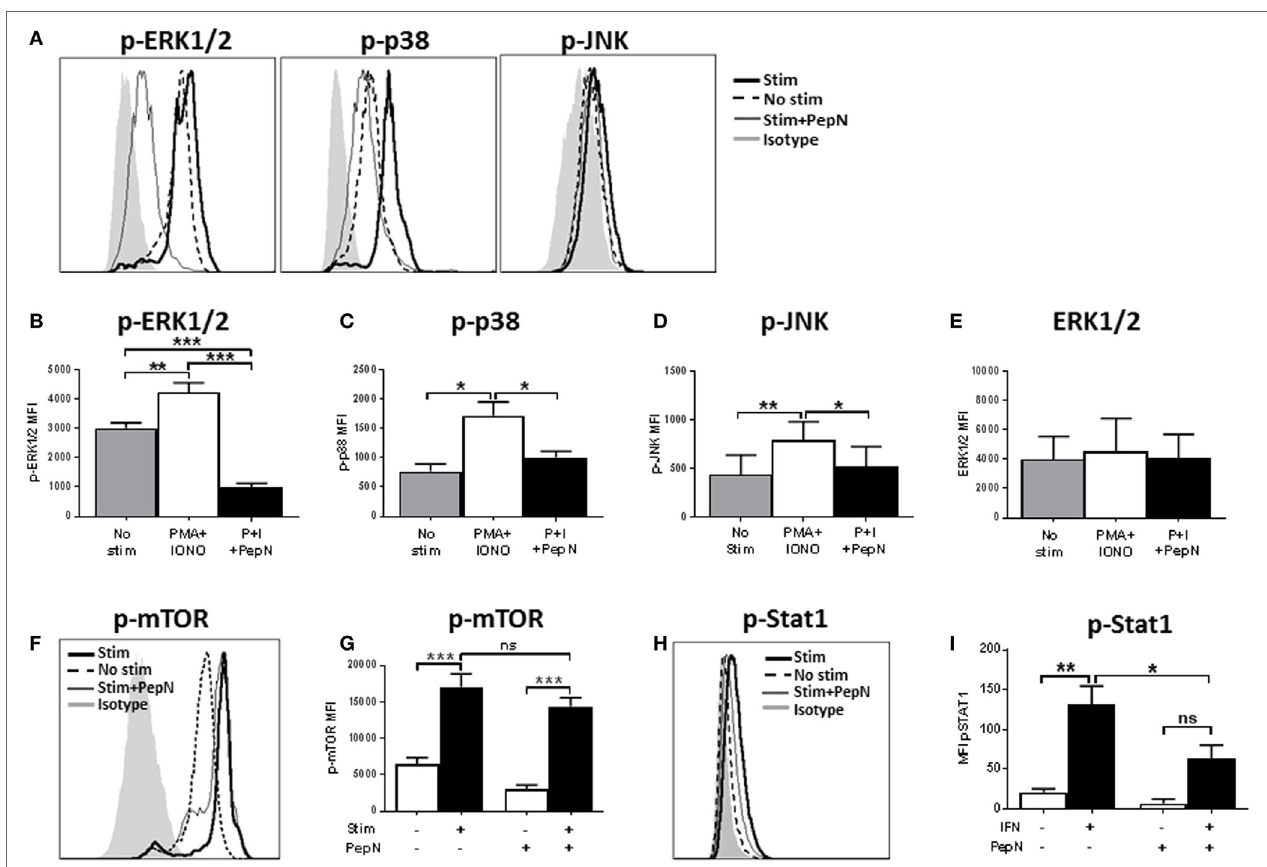
FigUre 9 | Aminopeptidase N (PepN) treatment significantly impairs many but not all molecules in the TCR signaling pathway. For analysis of TCR signaling, NP-specific cytotoxic T lymphocyte (CTL) were stimulated for 15 min with phorbol 12-myristate 13-acetate (PMA) + ionomycin (IONO) in the presence or absence of PepN followed by staining with anti-CD8 and antibody for the indicated signaling molecule. Representative histograms showing levels of phosphorylated ERK, p38, and Jun N-terminal kinase (JNK) are presented in (a) . The mean MFI ± SEM are shown for the level of phospho-ERK (b) , phospho-p38 (c) , phospho-JNK (D) , and total ERK protein (e) . Representative histograms (F) and mean MFI ± SEM (g) showing levels of phosphorylated mammalian target of rapamycin (mTOR). For the analysis of STAT1 activation, NP-specific CTL were stimulated for 15 min with type 1 IFN followed by staining with anti-phospho STAT1 antibody. Representative histograms are shown in (h) and mean MFI ± SEM in (i) . All data are from three to four independent experiments. * p < 0.05, ** p < 0.01, and *** p <